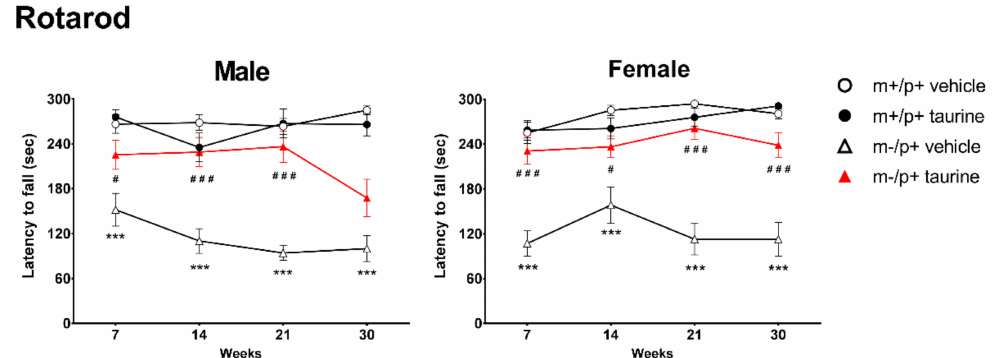
Figure 2. Taurine treatment improved motor coordination in AS ( Ube3a m − /p+ ) mice. Rotarod tests were carried out at four time points (7, 14, 21 and 30 weeks) on wild type (wt) and Ube3a m − /p+ mice (both treated (taurine) and untreated (vehicle)). Analyses were conducted by separating genders (male: left panel ; female: right panel ). Animals per group: male mice (wt + vehicle = 14, wt + taurine = 12, Ube3a m − /p+ + vehicle = 11, Ube3a m − /p+ + taurine = 11); female mice (wt + vehicle = 15, wt + taurine = 13, Ube3a m − /p+ + vehicle = 12, Ube3a m − /p+ + taurine = 14). Data are shown, for each time point, as media ± SEM. Effect of genotype: *** p < 0.001; effect of taurine treatment on Ube3a m − /p+ genotype: # p < 0.05, ### p <